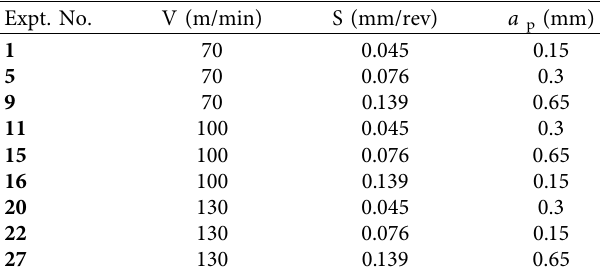
Table 5: The test dataset.